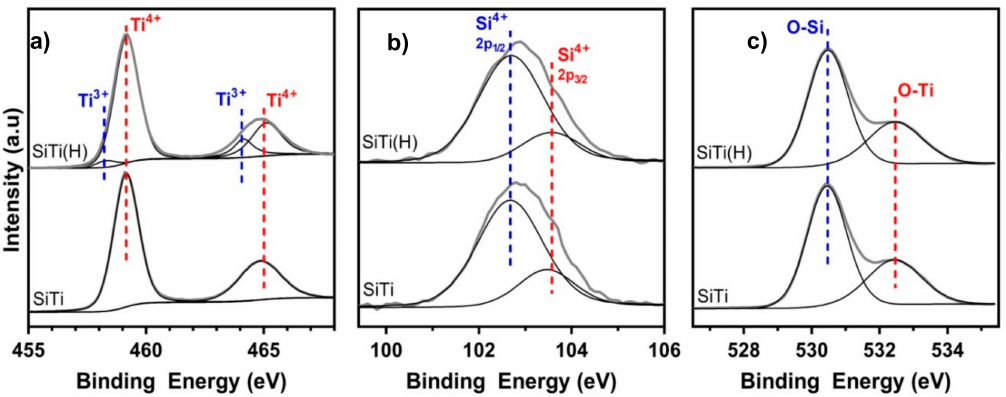
Figure 2. ( a ) Ti2p, ( b ) Si2p, and ( c ) O1s XPS spectra of the FSP-prepared SiTi materials before and after hydrogenation at 500 ◦ C.